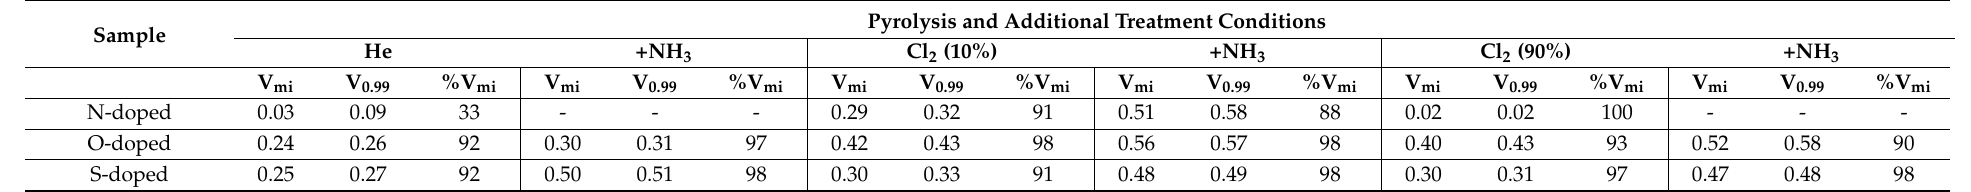
Table 4. Influence of pyrolysis conditions and additional ammonia annealing on micropore (V mi ) and total pore (V 0.99 ) volume values (cm 3 g − 1 ) of the obtained carbon materials. Sample